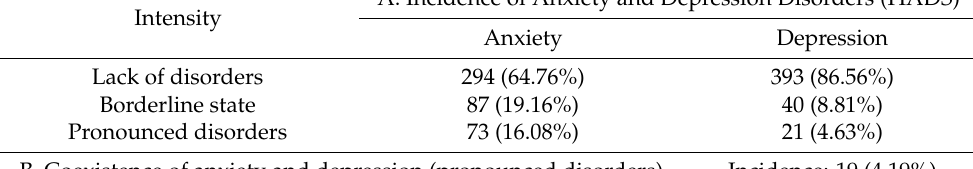
Table 4. Incidence of anxiety and depression disorders (A), incidence of coexistence of anxiety and depression